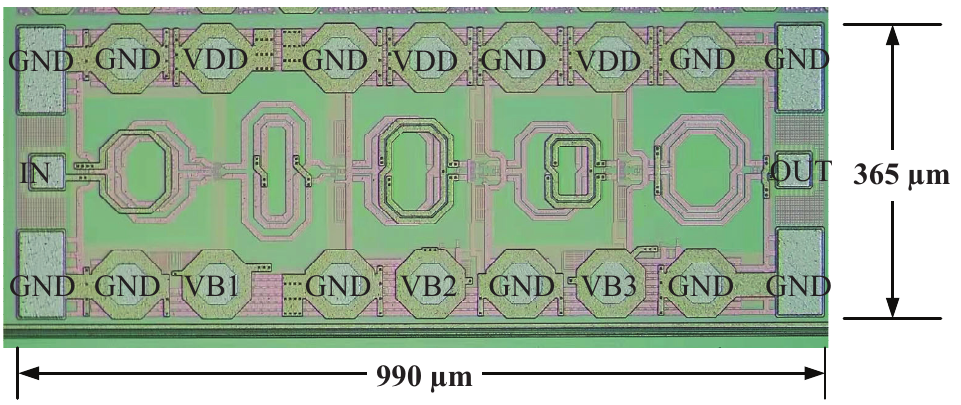
Figure 5. Die photo of the proposed